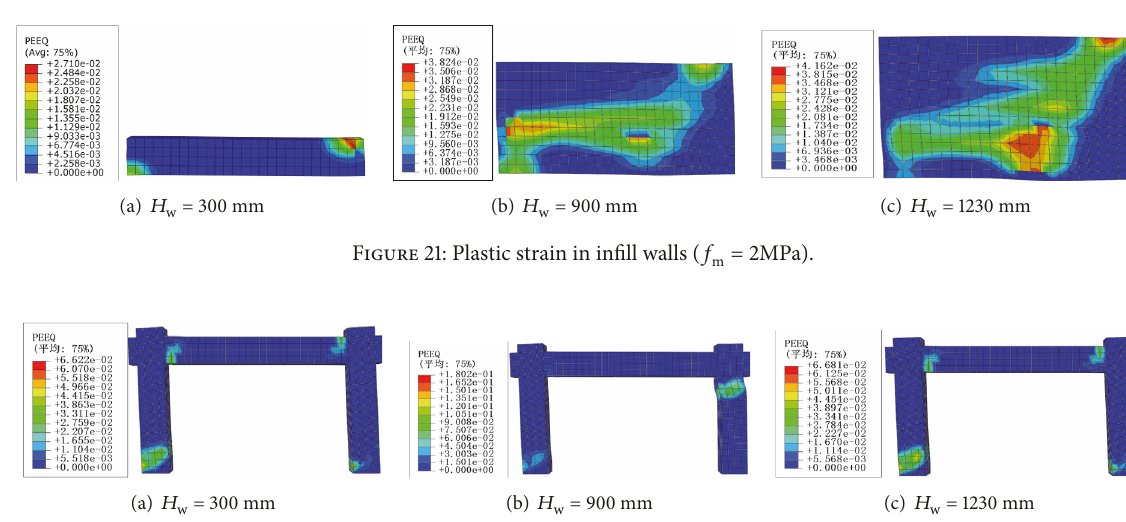
Figure 22: Plastic strain in frames partially infilled with masonry ( 𝑓 m = 3MPa).